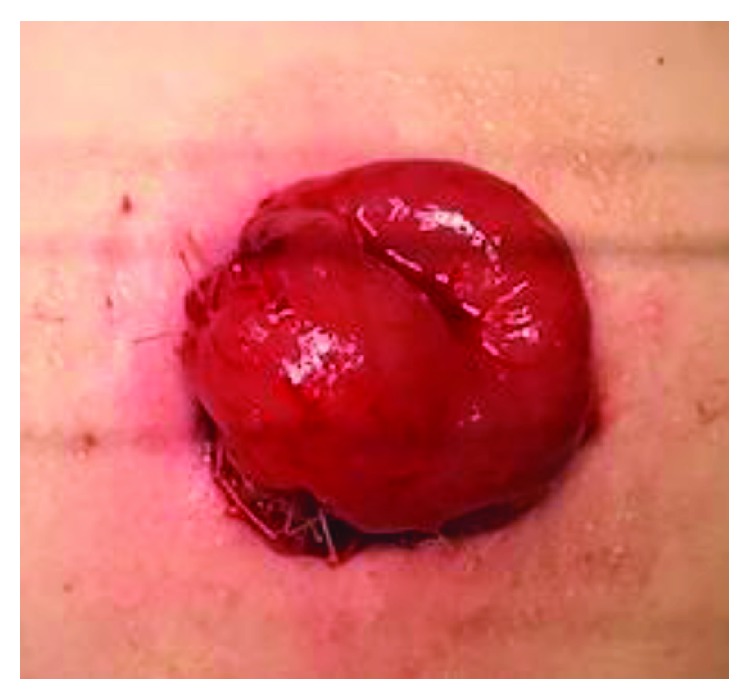
Completed ileostomy.